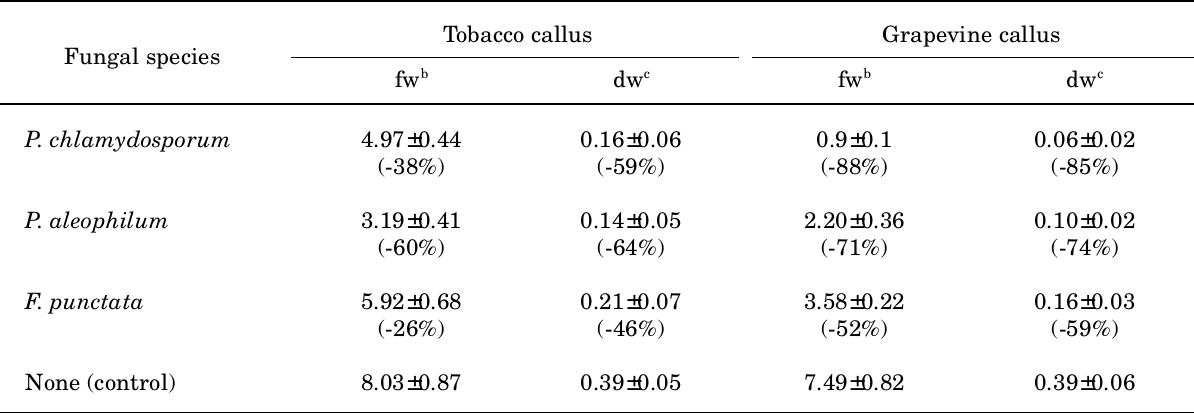
Table 4. Yield of 60-day-old callus tissue cultures of tobacco cv. White Burley and of grapevine cv. Italia grown in presence of P. chlamydosporum , P. aleophilum and F. punctata.